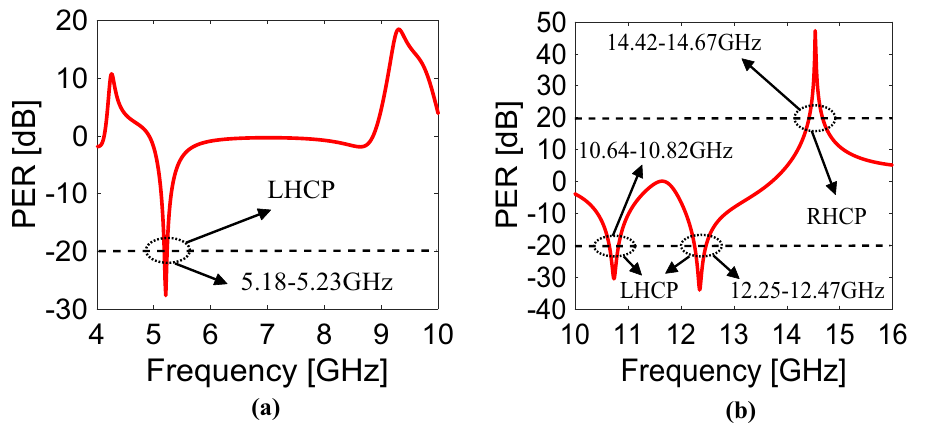
Figure 5. Polarization extinction ratio for ( a ) y-polarization, ( b ) x-polarization.